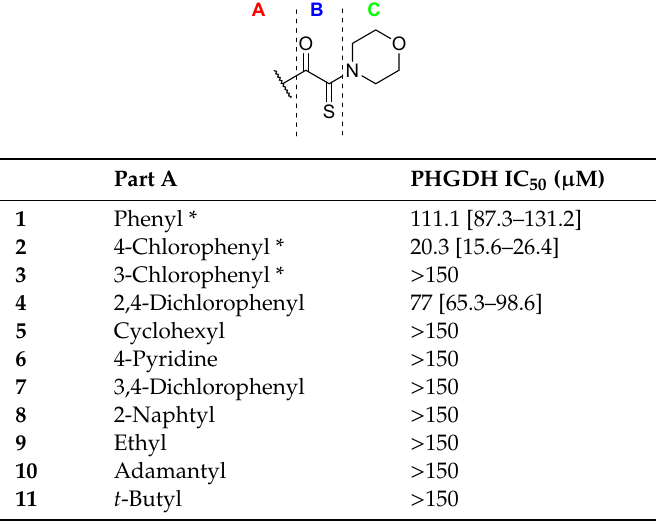
Table 2. Results of PHGDH inhibition for compounds 1 – 11 . All experiments were performed with at least triplicates and IC 50 values were determined in two or more independent experiments. * Compounds previously published in Ravez et al. [25]. A B C NO O S